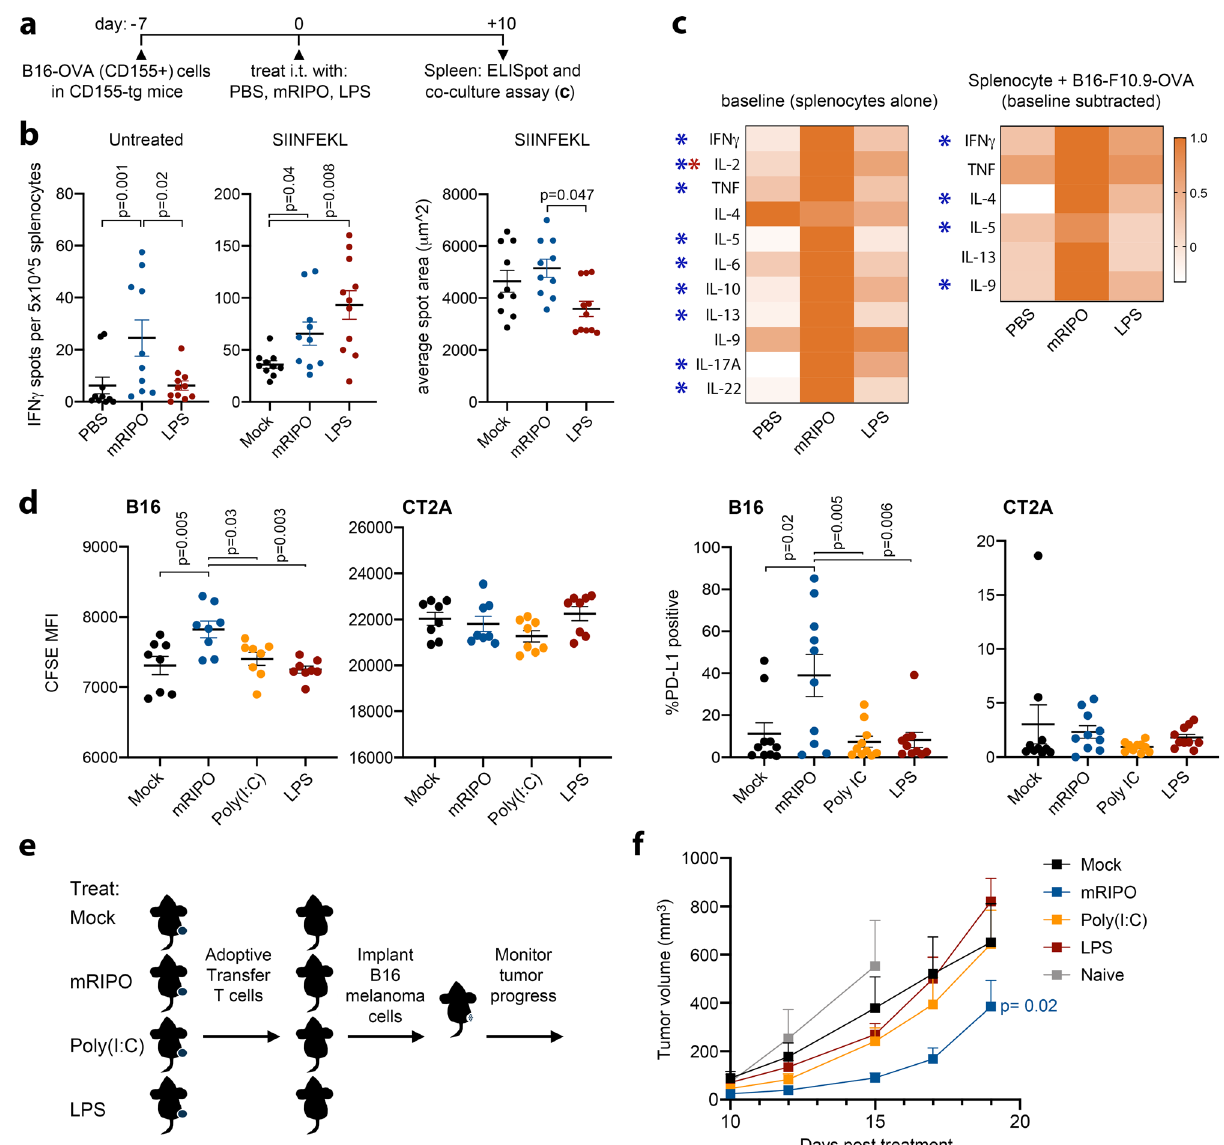
Fig. 8 Virotherapy selectively induces functional antitumor T cell immunity. a B16.F10.9 CD155 -OVA-implanted CD155-tg mice were treated as shown. b IFN γ ELISpot analysis of untreated splenocytes (left), or splenocytes cultured in the presence of SIINFEKL peptide (middle; untreated counts were subtracted). Right panel depicts average spot area ( n = 10 for PBS/ mRIPO, n = 11 LPS pooled from 2 experiments); see Supplementary Fig. 11 for extended data. P -values are from Tukey ’ s post-hoc (two-tailed) test. c Splenocytes from a subset of mice in ( b ) were tested in 48 h culture alone or with B16.F10.9- OVA cells (right). Supernatant cytokines are plotted for baseline (left) or antigen-speci fi c secretion (right; baseline secretion was subtracted from B16. F10.9.OVA co-culture values). Heatmaps were normalized to maximum value for each cytokine ( n = 8 mock/LPS; n = 7 mRIPO); only cytokines secreted above baseline are shown. (*) Tukey ’ s post-hoc p < 0.05 (two-tailed), baseline mRIPO vs mock (blue asterisks): IFN γ p = 0.03, IL-2 p = 0.004, TNF p = 0.03, IL-5 p = 0.01, IL-6 p = 0.02, IL-10 p = 0.04, IL-13 p = 0.008, IL-17A p = 0.01, IL-22 p = 0.004; baseline LPS vs mock (red asterisk): IL-2 p = 0.03; baseline subtracted mRIPO vs mock (blue asterisks): IFN γ p = 0.01, IL-4 p = 0.01, IL-5 p = 0.047, IL-9 p = 0.01. d Tumor-draining lymph nodes (TDLNs, inguinal lymph node, n = 8 mice/group) from CD155-tg mice bearing wt B16 tumors treated with mock, mRIPO, Poly(I:C), or LPS as in Fig. 8a were harvested 7 days after intratumor treatment. TDLN cells (5 × 10 5 ) were co-cultured with carboxy fl uorescein succinimidyl ester (CFSE)-labeled B16 or CT2A cells in vitro (3 × 10 3 ). CFSE median fl orescence intensity (left panels) and PD-L1 expression (right panels) were measured by fl ow cytometry for both cell lines after co-culture (48 h); see Supplementary Fig. 12 for gating and extended analyses; a representative series from three experiments is shown. P -values indicate Tukey ’ s post-hoc two-tailed test. e , f Wt B16 tumor-bearing mice were treated as in ( d ) ( n = 5/group). Ten days after treatment splenocytes were harvested and pooled by treatment. T cells were isolated by negative selection and adoptively transferred into naïve mice (2 × 10 6 T cells per mouse) receiving B16 wt tumor cell implants on the same day; mean tumor volume + SEM is shown ( f , n = 8 Mock/Poly(I:C), n = 7 mRIPO, n = 6 LPS, n = 4 naïve). P -value is from two-way ANOVA (two-tailed) comparing mice receiving T cells from mRIPO vs mock-treated mice; a representative series from two experiments is